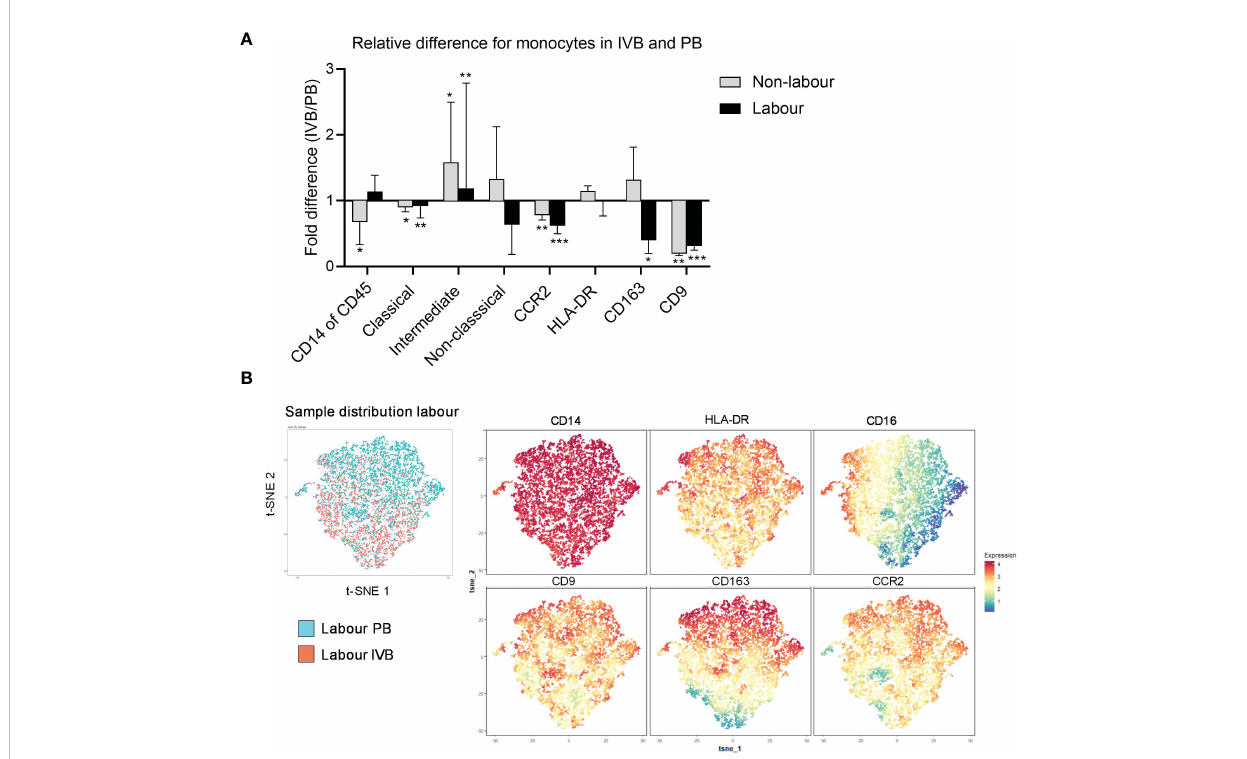
FIGURE 3 Intervillous monocytes display a different phenotype compared to peripheral monocytes. (A) Relative differences (fold change) between PB and IVB in labour and non-labour for the total proportion of CD14 + monocytes out of CD45 + mononuclear cells, subsets of monocytes out of total monocytes and the median fl uorescence intensity (MFI) of CCR2, HLA-DR, CD163 and CD9 in the total monocyte population. (B) Flow cytometric data on monocytes from PB and IVB from 3 individuals delivering with labour was visualised by t-SNE analysis. Sample distribution between PB and IVB (left) and marker expression projections (right) for are shown. Data is shown as median and interquartile range (A) . Statistical differences were determined with Wilcoxon signed rank test (A) , *p<0.05, **p<0.01,